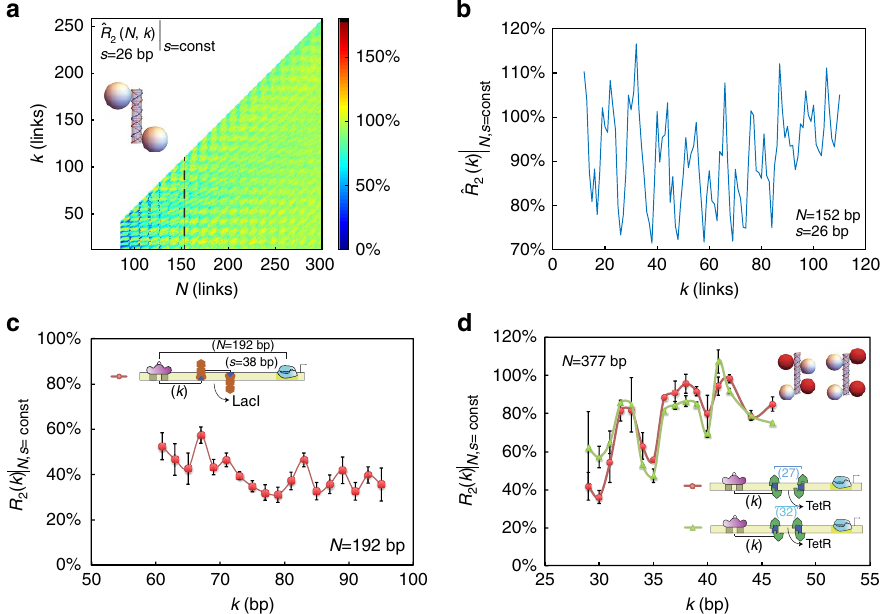
Figure 5 | Periodicity of a half-helical repeat. ( a ) Heat-map depiction of the probability-ratio level for a thick chain with two ‘out-of-phase’ protrusions taken at a fixed inter-site distance ( s ). Inset: chain schematic showing the Z-shaped binding architecture. ( b ) Cross-section of the heat map at N ¼ 152 links, showing oscillations with a 5- to 6-bp periodicity. Protrusion size was taken to be 5.44nm in diameter. ( c ) Expression level ratio data for LacI synthetic enhancers with tandem binding sites spaced at 38bp. ( d ) Expression level ratio data for synthetic enhancers with tandems of TetR-binding sites that are spaced by half integer ( s ¼ 27bp, red line) and integer multiples of the helical repeat ( s ¼ 32bp, green line), showing identical regulatory function. Inset: the structural binding model showing a thick chain with two dumbbell-shaped protrusions positioned in-phase (right) and out-of-phase (left), respectively. Error bars correspond to the s.d. from multiple